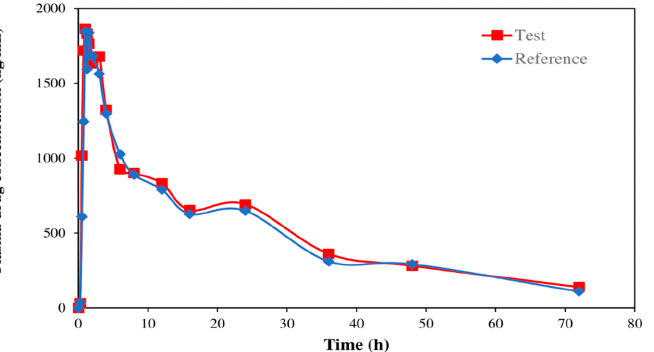
Figure 5. The etoricoxib pharmacokinetic profile of test and reference product of etoricoxib 120 mg for a volunteer.